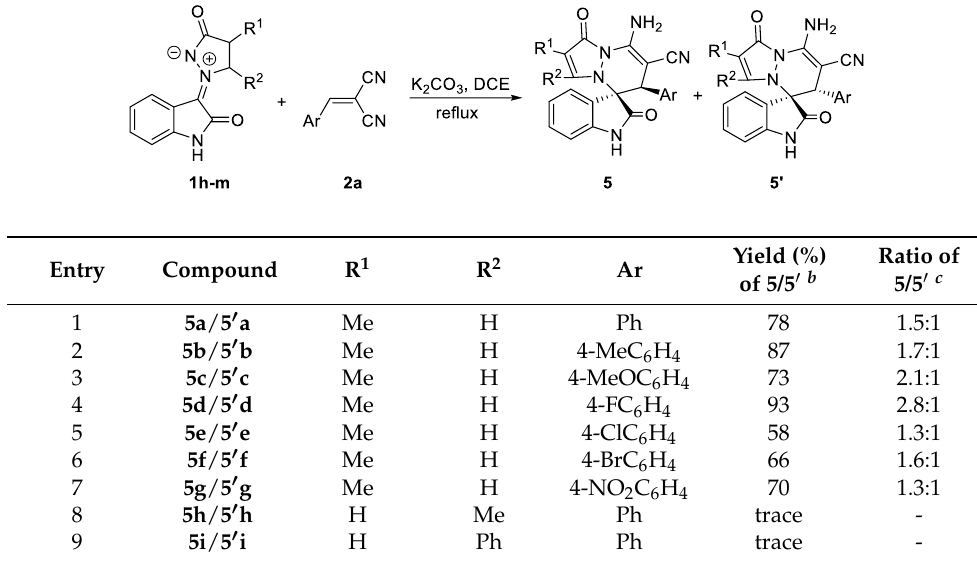
Table 4. Synthesis of dicyclic spiropyridazine oxindoles 5 and 5′ from isatin N , N ’ -cyclic azomethine imines 1h – m and Knoevenagel adducts 2 a .